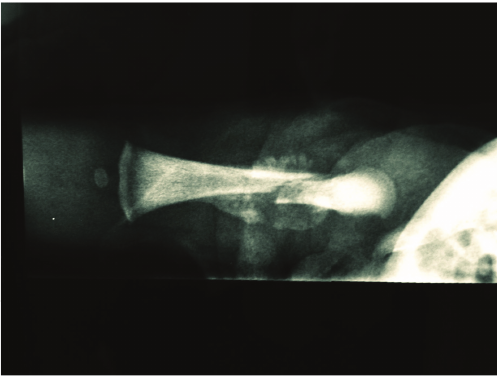
Figure 3: Rx showing the healing of the